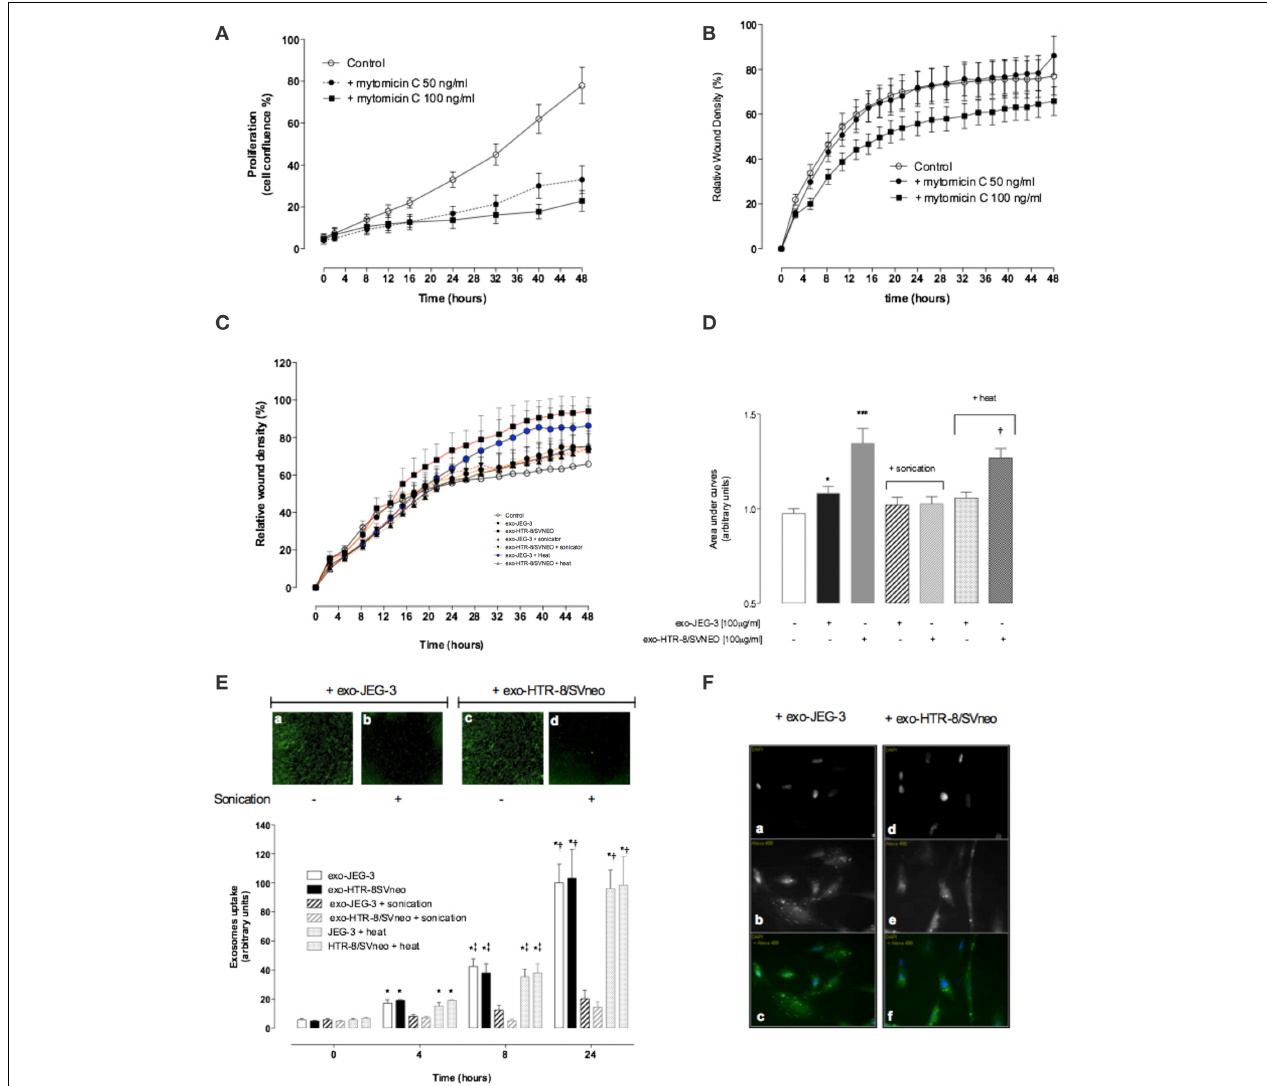
FIGURE 4 | EVT-derived exosomes effects on hVSMC migration. hVSMC were grown to confluence in 231 media and a wound was made using 96 well WoundMaker (see Materials and Methods). hVSMC Migration was measured in absence or presence of 100ug/ml of exosomes from JEG-3 and HTR-8/SVneo cells and mitomycin C (100ng/ml) for 48h. Exosome particles were subjected to sonication ( + sonication) or heat inactivation ( + heat) before exposure to hVSMC cells (A,B) hVSMC proliferation and migration in the presence of Mitomycin C, respectively. (C) Time course of wound closure for hVSMC expressed as relative wound density (%).